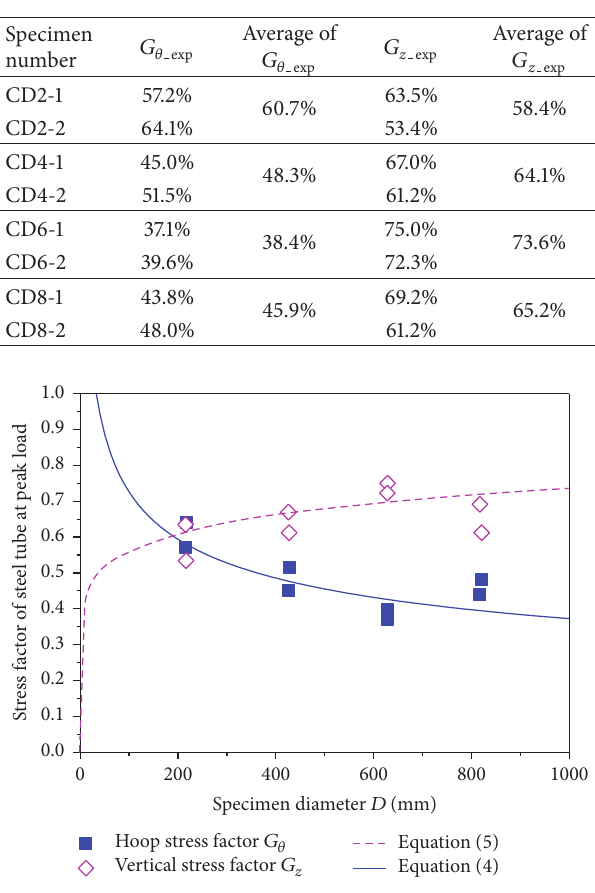
Table 6: Stress factors of steel tube at peak load.